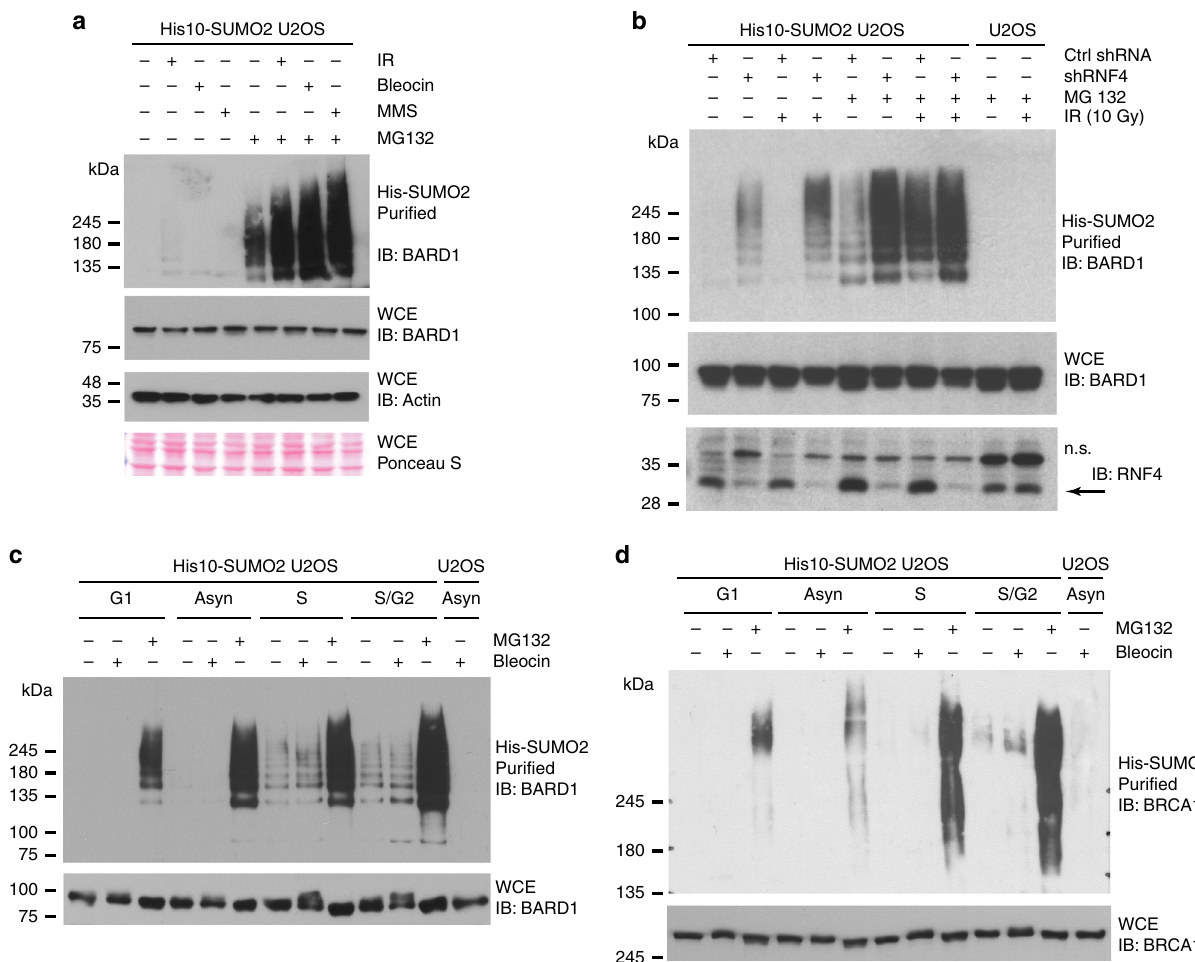
Fig. 5 BARD1 SUMOylation is enhanced in response to DNA damage and proteasome inhibition. a BARD1 is SUMOylated in response to DNA damage and SUMOylated BARD1 is degraded by the proteasome. U2OS cells stably expressing His10-SUMO2 were either mock-treated or treated with MG132 (10 µ M) to inhibit the proteasome. One hour after the start of MG132 treatment, the cells were either mock-treated or irradiated with IR (10 Gy), or treated with Bleocin (5 µ g/ml) or MMS (0.001%). The cells were subsequently incubated for 4 h and lysed. His10-SUMO2 conjugates were puri fi ed (PD) and analyzed by immunoblotting. Whole-cell extracts (WCE) were analyzed by immunoblotting to determine the total levels of BARD1. b Similar to a , RNF4-depleted cells were either mock-treated or treated with MG132 and/or IR (10 Gy) treated as indicated. His10-SUMO2-puri fi ed samples and whole-cell extracts were analyzed by immunoblotting using an antibody directed against BARD1. n.s. indicates non-speci fi c bands. c Cell cycle stage-dependent SUMOylation of BARD1. Similar to a and b , U2OS cells stably expressing His10-SUMO2 were arrested in the G1, S, or G2/M-phase of the cell cycle. These cells were either DMSO-treated or treated with Bleocin (5 µ g/ml) or MG132 (10 µ M) as indicated. His10-SUMO2-puri fi ed samples and whole-cell extracts were analyzed by immunoblotting using an antibody directed against BARD1. d Cell cycle stage-dependent SUMOylation of BRCA1. Similar to c , His10-SUMO2-puri fi ed samples and whole-cell extracts protein samples from G1, S, or G2/M were analyzed by immunoblotting using an antibody directed against BRCA1. Knockdown ef fi ciency and the puri fi cation of His10-SUMO2 conjugates were veri fi ed by immunoblotting, shown in Supplementary Fig. 4. Unprocessed full- size scans of blots are provided in Supplementary Fig. 9. Experiments presented in this section as well as in supplementary fi gure section was repeated two to four times to test the reproducibility of data. The experiments described in a were repeated two times, in b four times, and three times in c and d . Unprocessed full-size scans of blots are provided in Supplementary Fig.